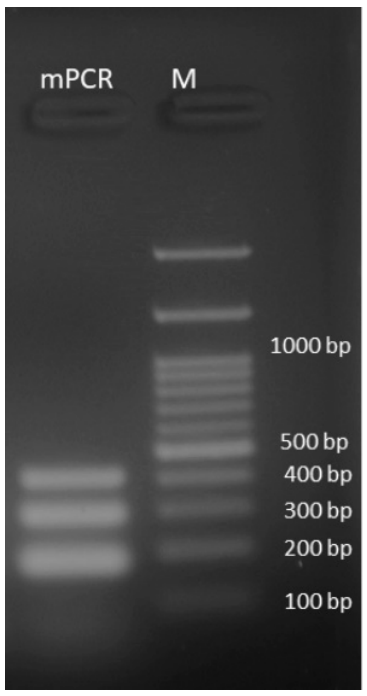
Figure 3. Agarose gel visualization of the amplification products of the developed mPCR performed on the pooled genomic DNA of S31 and E25. The developed mPCR specifically detected the three genes simultaneously, ( nuc : 192 bp; mec A: 310 bp, and van A/B: 420 bp). M: 100 bp DNA ladder.